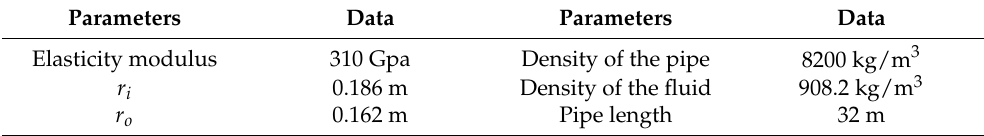
Table 2. Material and geometry parameters used in studies by Xu [42] and Housner [46].